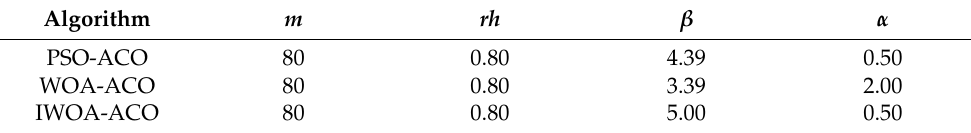
Figure 8. The convergence curve of the evaluation function in the simulation of flat environment. Table 3. The parameter values of ACO in the simulation of flat environment.